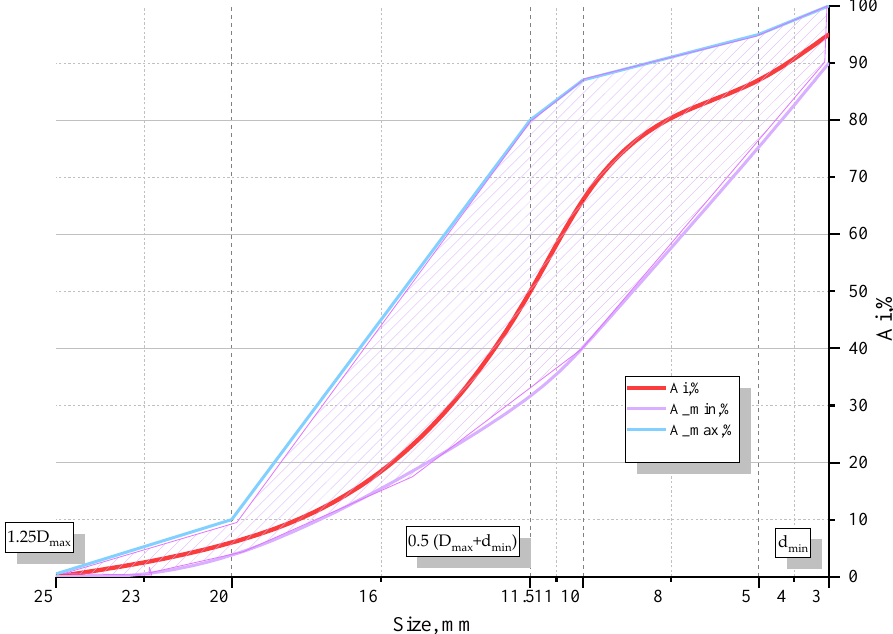
Figure 2. Granulometric curve for coarse aggregates (Ai — total residues on a sieve of given cell size, Ai_max, Ai_min — maximum and minimum values of total residues).